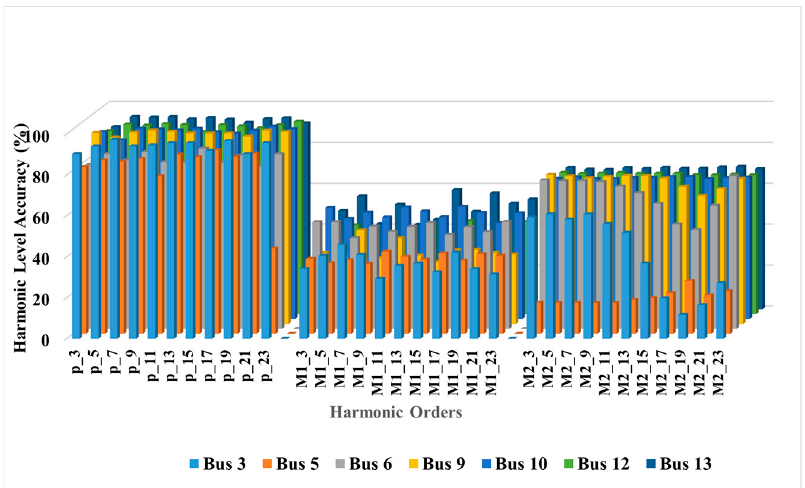
Figure 7. Comparison of harmonic level classifiers’ accuracies of different techniques for scenario Base 6: P: the proposed method, M1: GALS [11] and M2: method of [8].